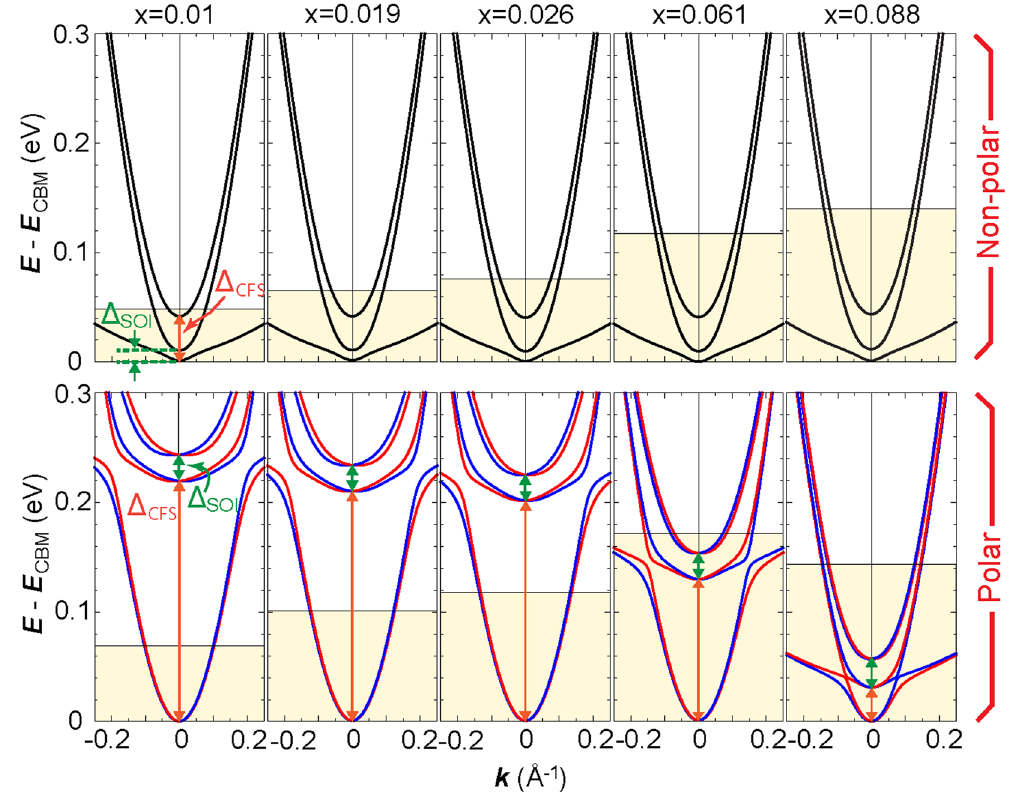
Figure 4. Electronic structures of La-doped BaTiO 3 films. Band structure of La-doped BTO calculated at various La concentrations, x , for the non-polar (polar) structure in the upper (lower) panel. The energy separations of bands caused by crystal field splitting and spin orbit interactions are by Δ CFS and Δ SOI , respectively. For the polar cases, red and blue colours represent the opposite spin states of the bands (red: spins pointing out of the page; blue: spins pointing inward). The shaded area denotes the energy range within which states are occupied. E CBM corresponds to the energy level of the conduction band